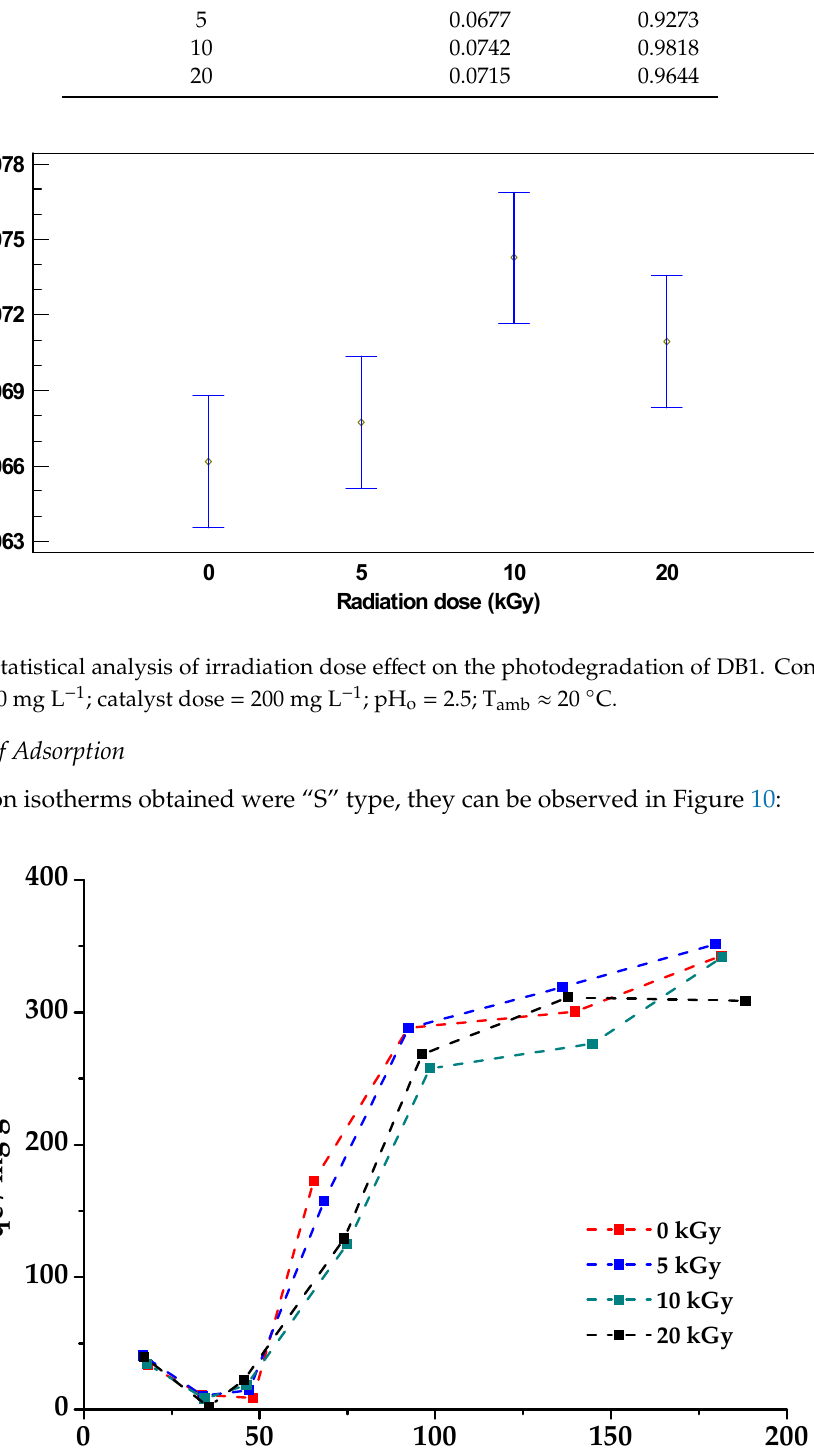
Table 2. Rate constants for pseudo first order reaction at di ff erent irradiation doses.